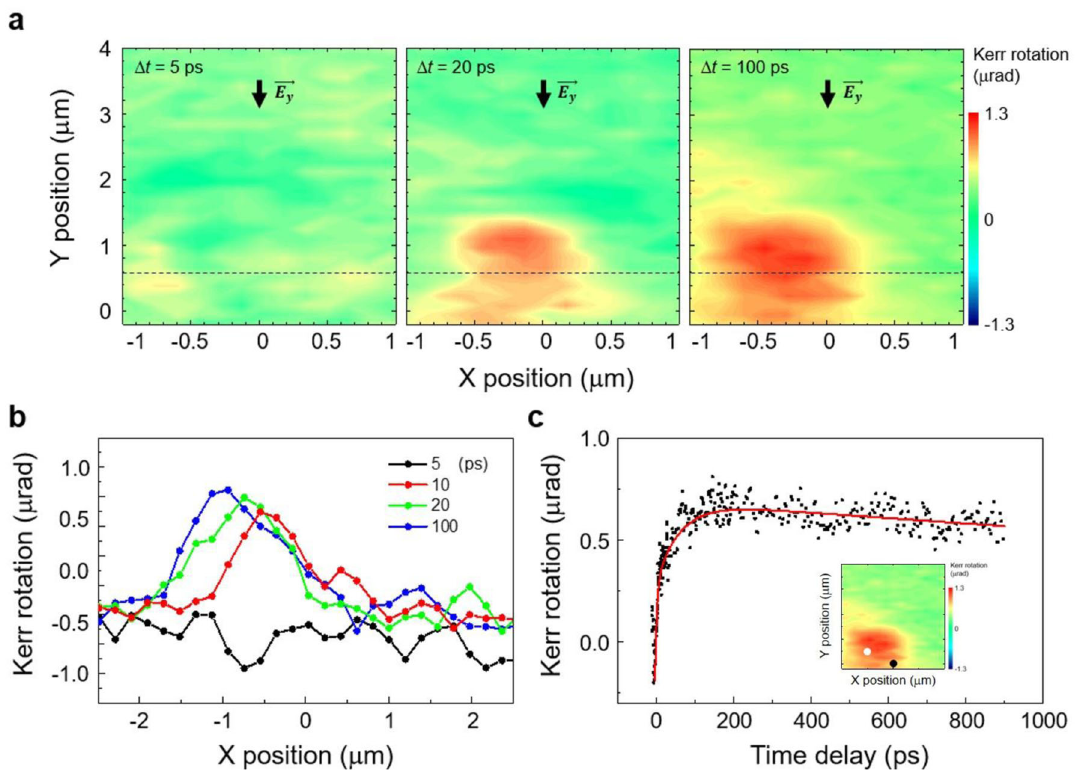
Fig. 3 Experiment data from the TRKR microscopy. a Time-resolved dynamics of the Kerr-rotation angle show the spatial shift of the valley-polarized electron wavepackets with increasing pump-probe delay Δ t at V G = 2 V. In the experiment, the center of the remote pump was excited at a fi xed position of (0, 0) and the probe was scanned the designated area at each Δ t . The dashed line is a line cut for the time-dependent measurement. The corresponding data are shown in ( b ). b The one-dimensional line cut measurements of Kerr-rotation angles are displayed for several pump-probe delays. c Measured time-resolved Kerr-rotation angle (black dots) shows a long decaying transient. Solid red line shows a fi tting curve of the rising and decaying of Kerr- rotation signal. Inset: the measurement was done when V G = 2 V, with the center of the remote pump is at (0, 0) μ m and the center of the probe is at ( − 0.5, 0.5) μ m as denoted by a black dot and white dot on the scanning result,